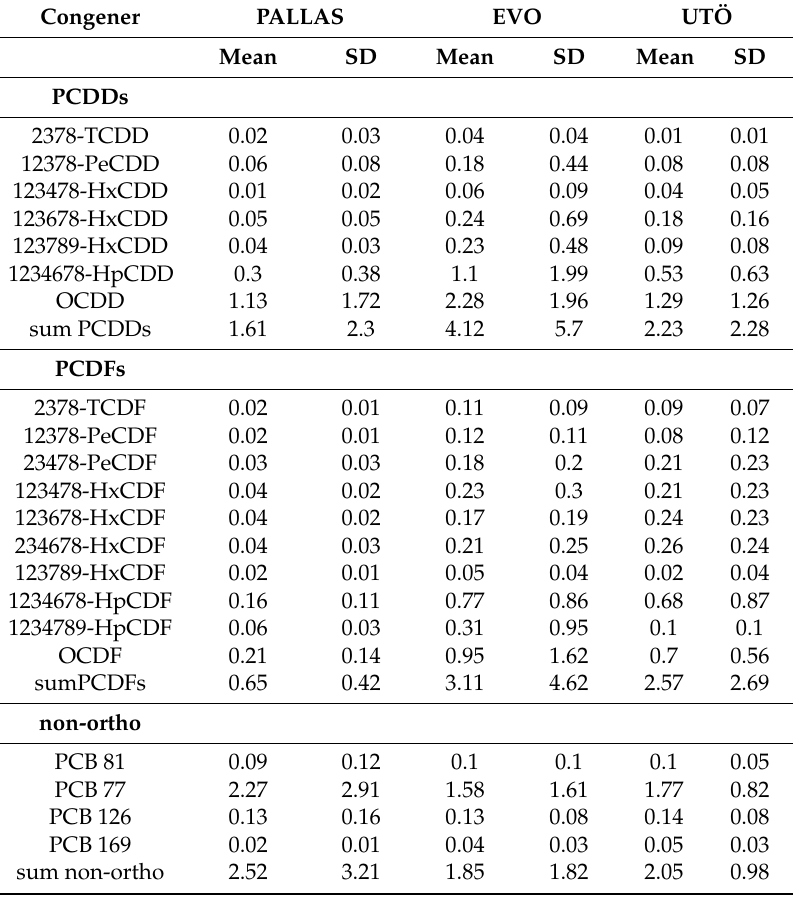
Table 1. Concentrations (mean and standard deviations, SD) of PCDD/Fs and PCBs (pg/L) in Pallas, Evo, and